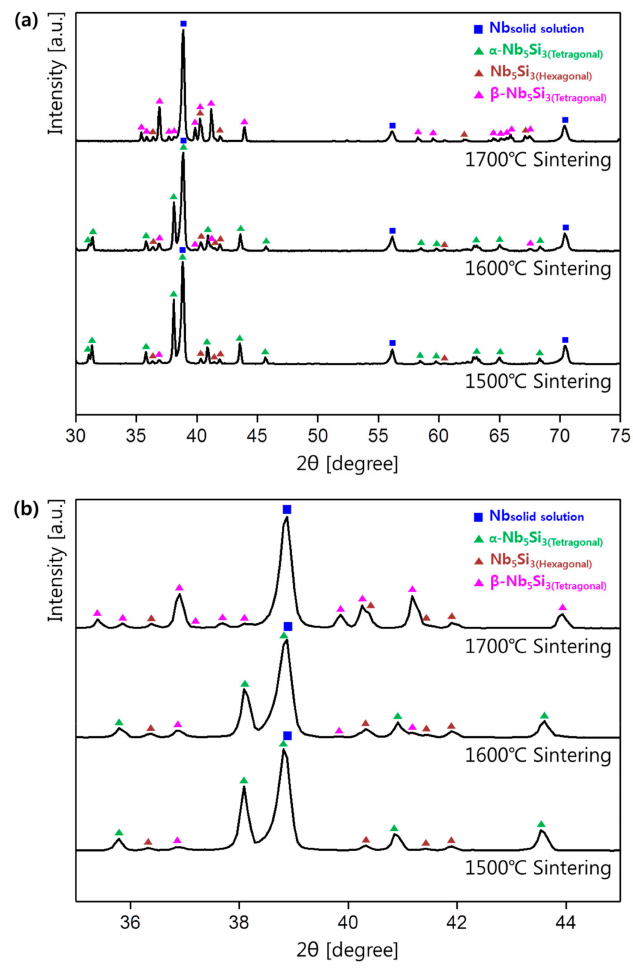
Figure 6. ( a ) XRD patterns of the compacts sintered at 1500 ◦ , 1600 ◦ , and 1700 ◦ and ( b ) expanded XRD patterns in the 2 θ range of 35–45 ◦